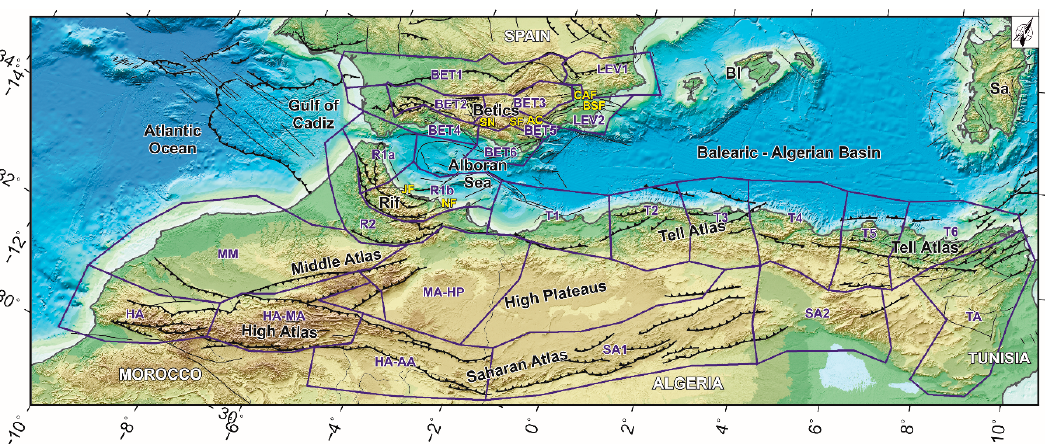
Figure 1. Simplified tectonic map of Northwestern Africa and Southeastern Iberia. Mapped faults are re-drawn from [23] and references therein. Seismic source zones (Betics seismic source zones—BET1, BET2, BET3, BET4, BET5, BET6; Atlas seismogenic sources—HA, HA-AA, HA-MA, SA1, SA2, TA represent High, Middle, Saharan, and Tunisian Atlas, as well as the northeastern part of the Anti-Atlas; Levante seismogenic regions—LEV1, LEV2; Moroccan Meseta-High Plateaus seismic source zones—MA-HP, MM; Rif seismogenic sources—R1a, R1b, R2; Tell seismogenic source zones—T1, T2, T3, T4, T5, T6) analyzed in this study are also reported as blue solid polygons [24,25]. The map is plotted in an oblique Mercator